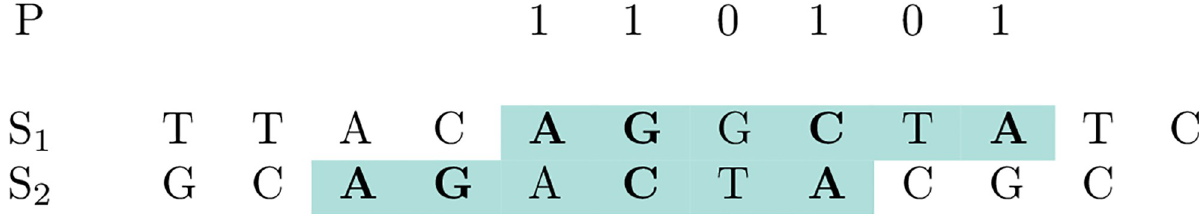
Fig 1. Binary pattern P = ‘110101’’ (‘1’) and don’t-care positions (‘0’) and a spaced word ‘A G � C � A’ with respect to P , occurring in sequences S 1 and S 2 . The occurrence of the same spaced word in two different sequences is called a Spaced-word Match (SpaM) . A SpaM w.r.t. P is, thus, a local gap- free alignment where matching residues are aligned at the match positions of P , while mismatches are possible at the don’t-care positions . In the above toy example, we find at the don’t care positions one mismatch (A-G) and one match (T-T). A score can be calculated for each SpaM based on the residues aligned to each other at the don’t-care positions . If the number of don’t-care positions in the underlying pattern P is sufficiently large, ‘homologous’ SpaMs can be reliably distinguished from background by their scores [34].